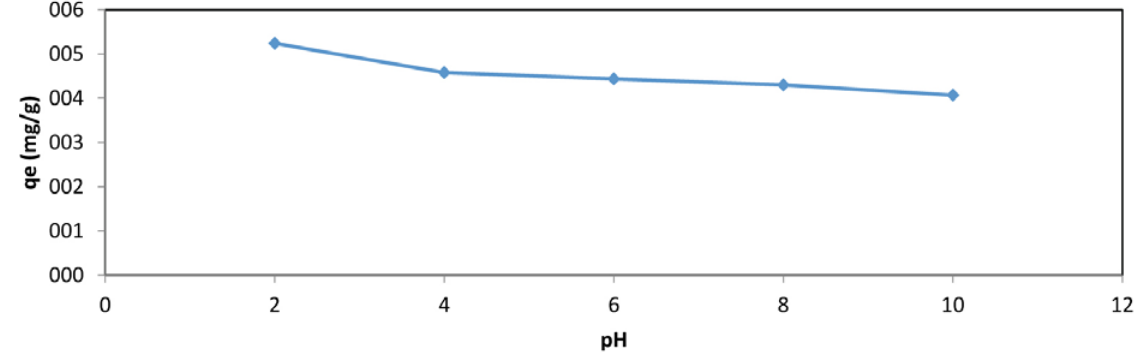
Figure 2. The effect of pH on the equilibrium sorption capacities of sweetgum bark, for 2,4-DCP